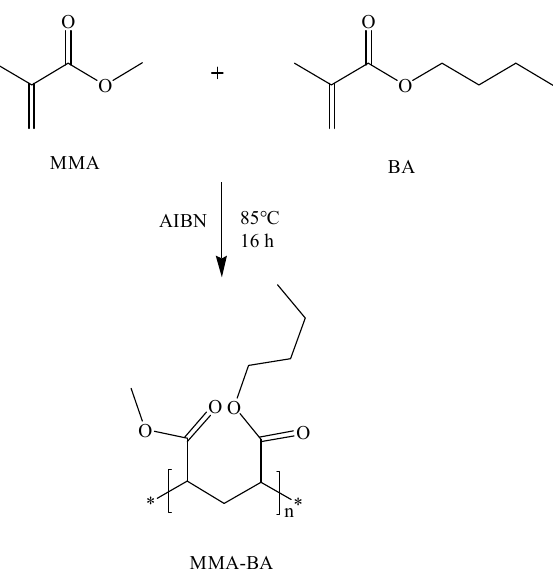
Figure 1. The free radical copolymerization reaction scheme of methyl methacrylate (MMA) and butyl acrylate (BA) resulting in plasticizer-free ion-selective membrane matrix.